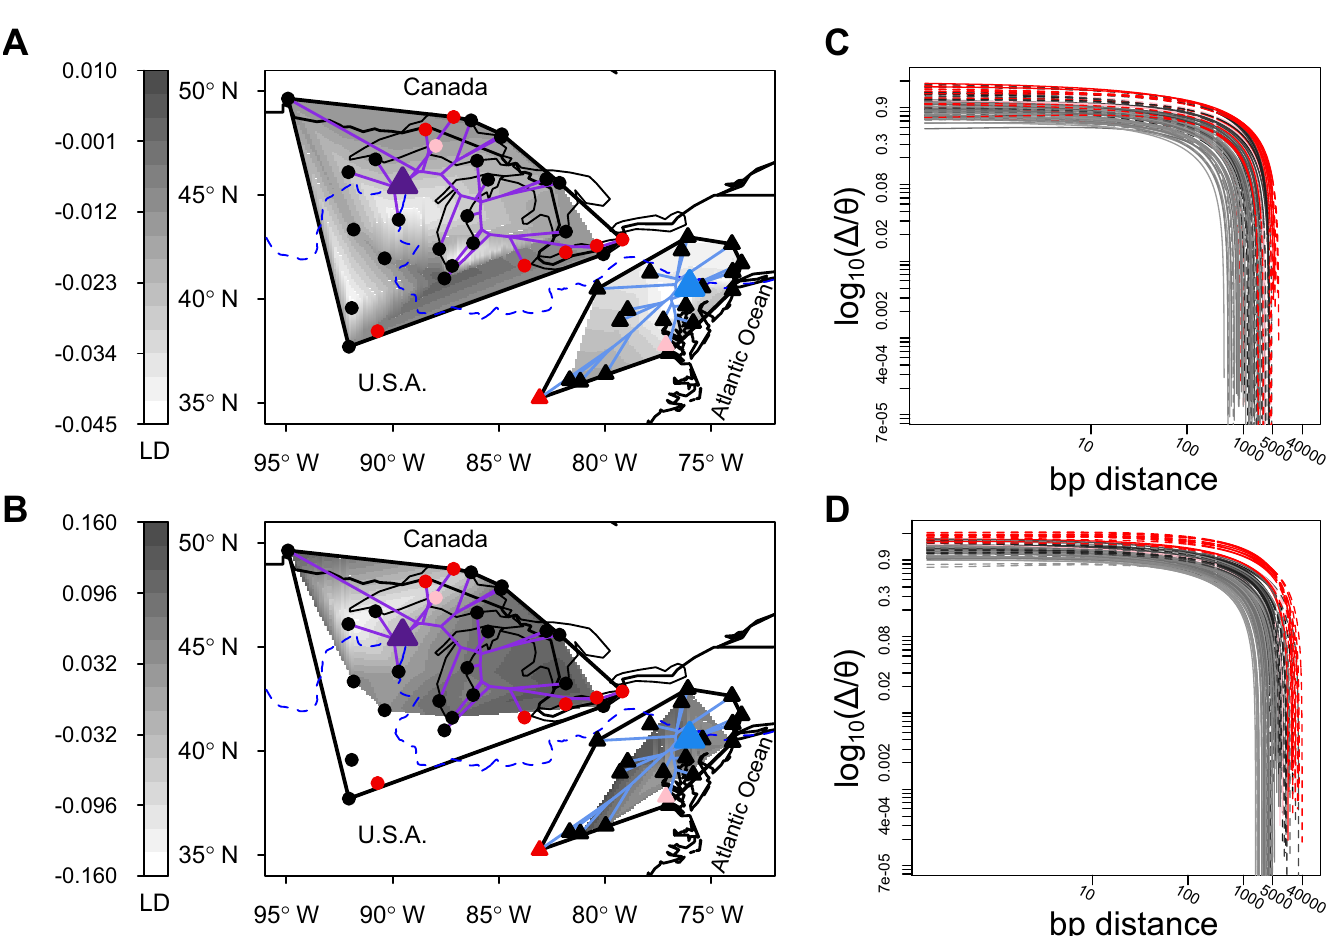
Fig 1. Geographic pattern of linkage disequilibrium (LD, distance-corrected r 2 between pairs of SNPs) in North American Arabidopsis lyrata (A&B) and the correlation of zygosity ( Δ ) scaled by the level of genome-wide heterozygosity ( θ ) (C&D). (A) Average genome-wide LD for intergenic regions. (B) Average LD for the gene FPA that is involved in the autonomous pathway of flowering time regulation. Darker gray shading for A&B indicates higher levels of LD; both surfaces were estimated based on outcrossing populations only. Minimum convex polygon hulls surrounding populations of the western and eastern ancestral genetic clusters are drawn in black. Triangles indicate the core areas from which recolonization began after the most recent glacial maximum. Lines from these cores are recolonization routes revealed by projecting the population phylogeny on the map. Circles are the populations sampled in this study: outcrossing (black), mixed-mating (pink), and selfing (red). Unshaded areas within the polygon hulls are regions with missing data for outcrossing populations. The dashed blue line indicates the maximum extent of the ice sheet during the last glacial maximum. LD increased with increasing distance from the core areas. The correlation of zygosity ( Δ ) across intergenic (C) and genic (D) regions for 104 individual genomes as estimated by ML R HO . Solid lines depict individuals from the eastern genetic cluster and dashed lines from the western genetic cluster, respectively. Individuals from mixed-mating populations are depicted in pink, and from selfing populations in red. For individuals from outcrossing populations the grayscale gradient indicates individuals from the range center (gray) to the range edge